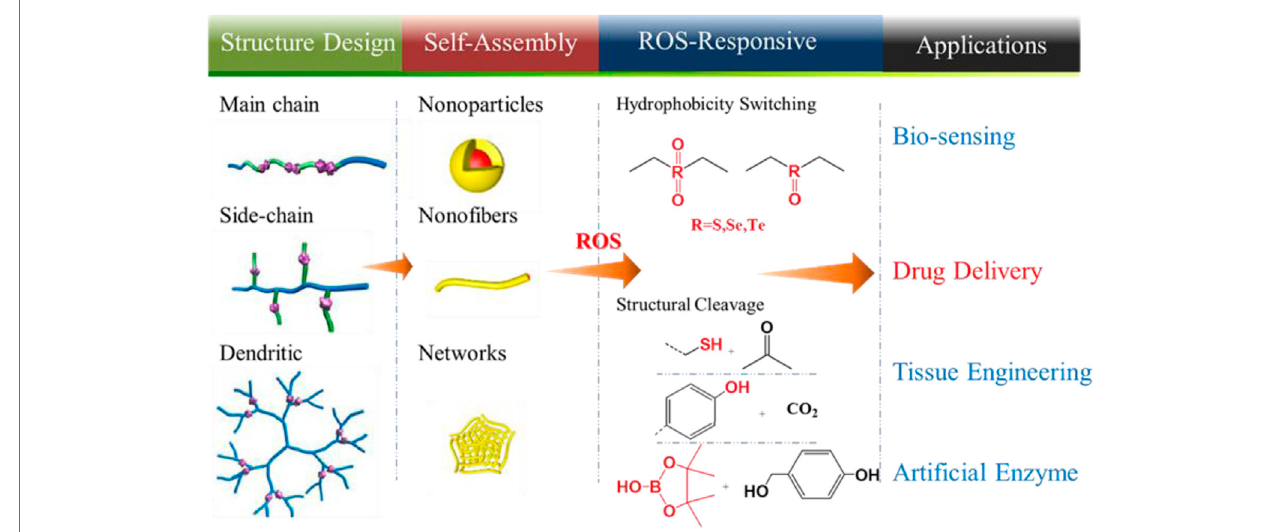
FIGURE 1 | Structure design and technological process of ROS-responsive polymers for drug delivery systems (Hu et al., 2020). Copyright 2020, the American Chemical Society.